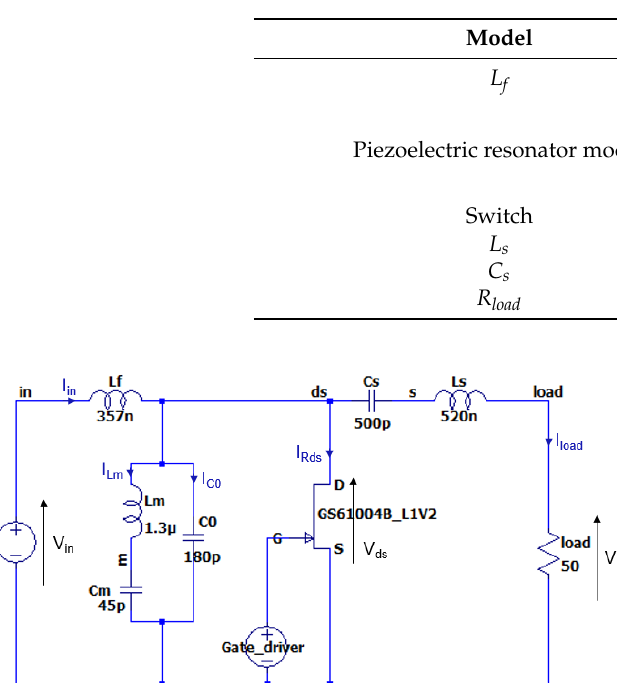
Table 3. Values of the components of the L − piezo converter.